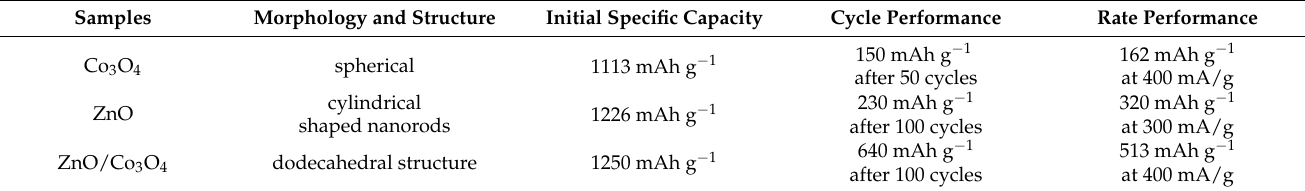
Table 2. Morphology and electrochemical properties of relevant metal oxides.